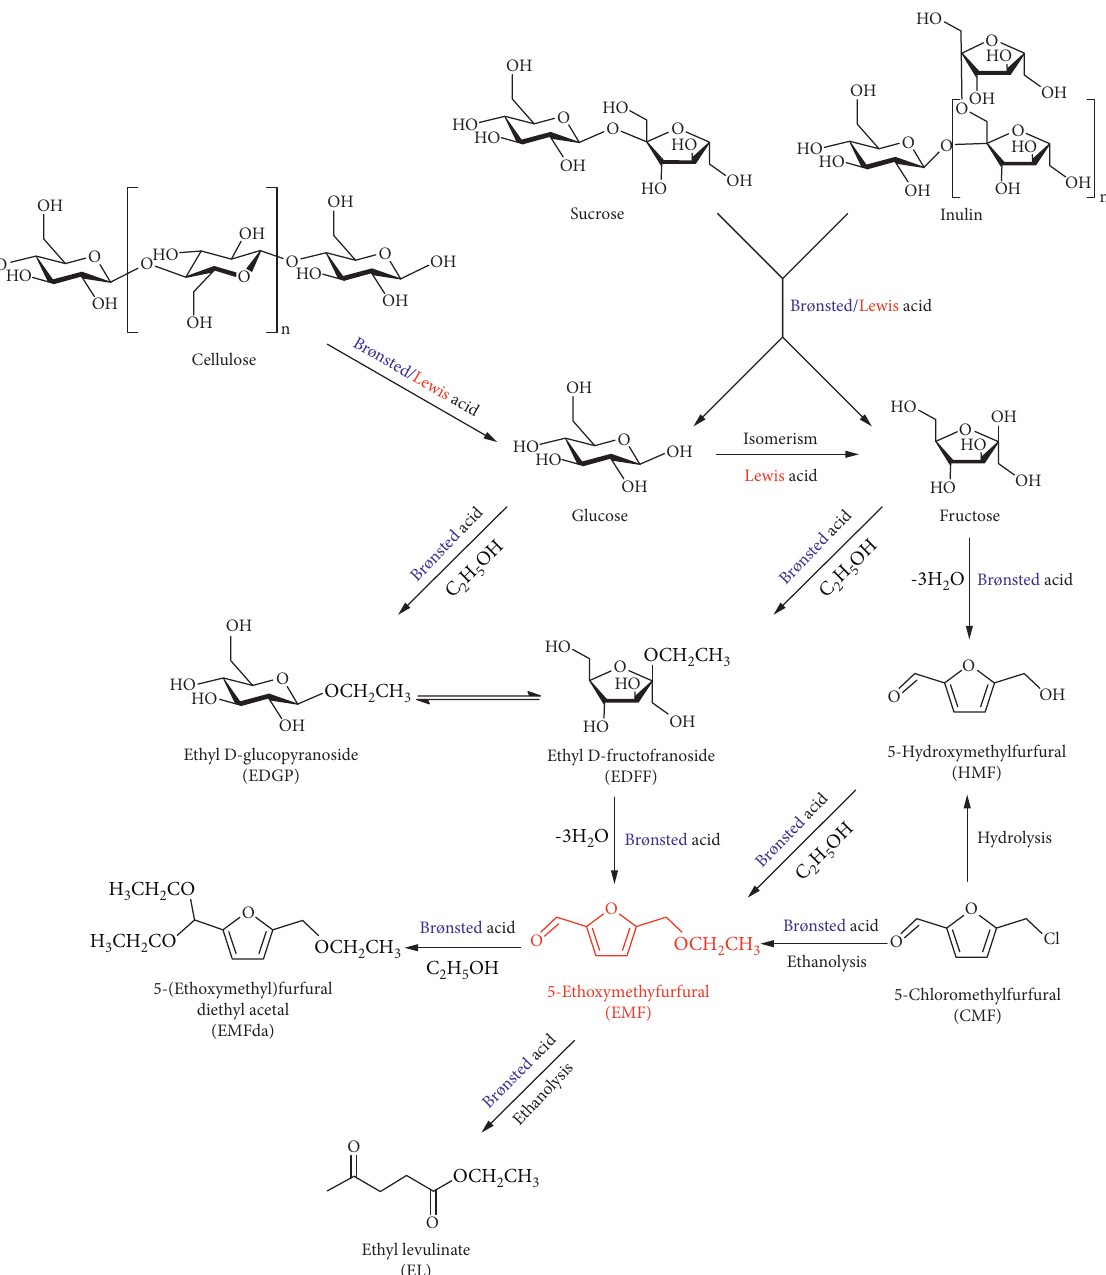
Scheme 2: The reaction paths of synthesising EMF from